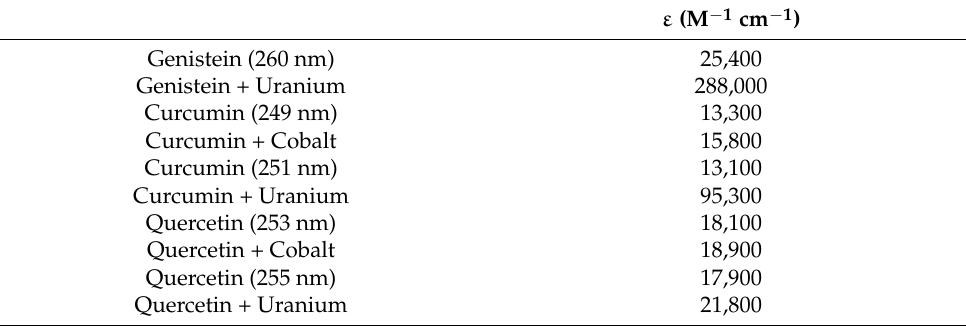
Figure 2. UV–visible spectra of metals and nutraceuticals in phosphate buffer (pH 7.4): ( A ) genistein (10 µM) with uranium (10 µM); ( B ) curcumin (10 µM) with uranium (10 µM) or cobalt (10 µM); ( C ) quercetin (10 µM) with uranium (10 µM) or cobalt (10 µM). Table 1. Molar absorption coefficients of nutraceuticals and metal complexes.